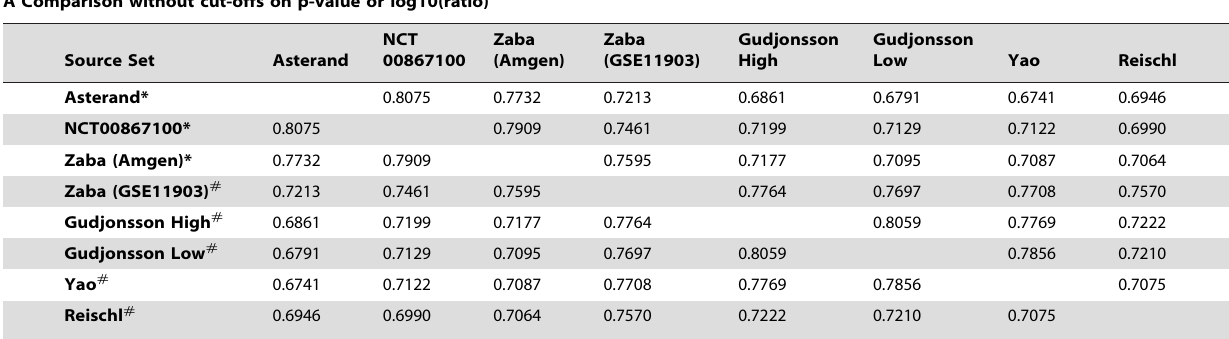
A Comparison without cut-offs on p-value or log10(ratio)